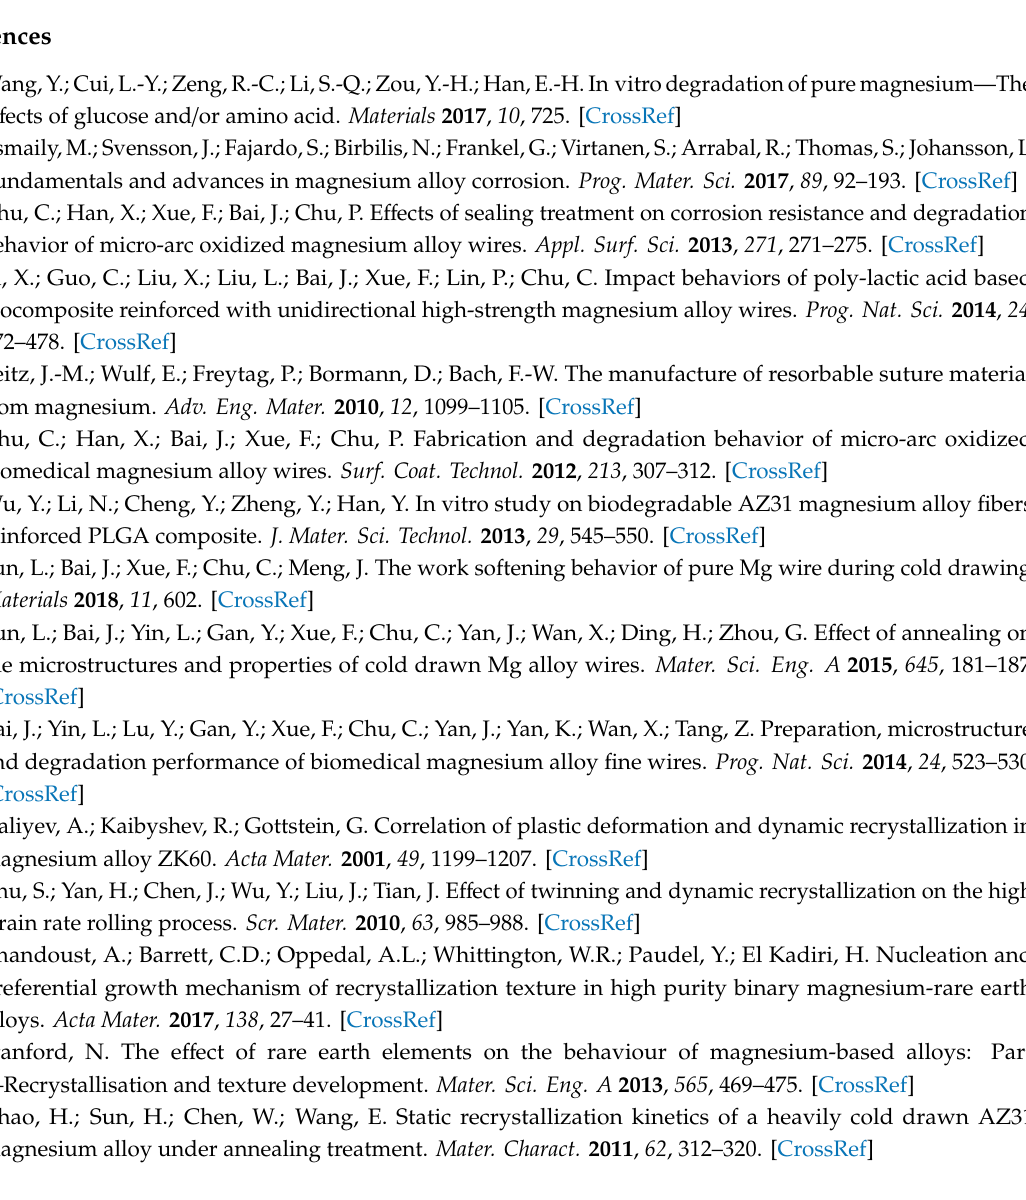
Figure S1: Strain-stress curves of Mg wires annealed at di ff erent temperature: (a) 150 ◦ C; (b) 200 ◦ C; (c) 250 ◦ C; (d) 300 ◦ C; (e) 350 ◦ C, Figure S2: Strain-stress curves of thin Mg wires (0.2 mm in diameter) with true strain of 138% after di ff erent annealing treatments, Figure S3: Annealed microstructures of pure Mg with di ff erent annealing process. (a) 150 ◦ C; (b) 200 ◦ C; (c) 250 ◦ C; (d) 300 ◦ C; (e) 350 ◦ C, Table S1: The statistic results of tensile test for thin Mg wires with diameter of 0.2 mm after di ff erent annealing